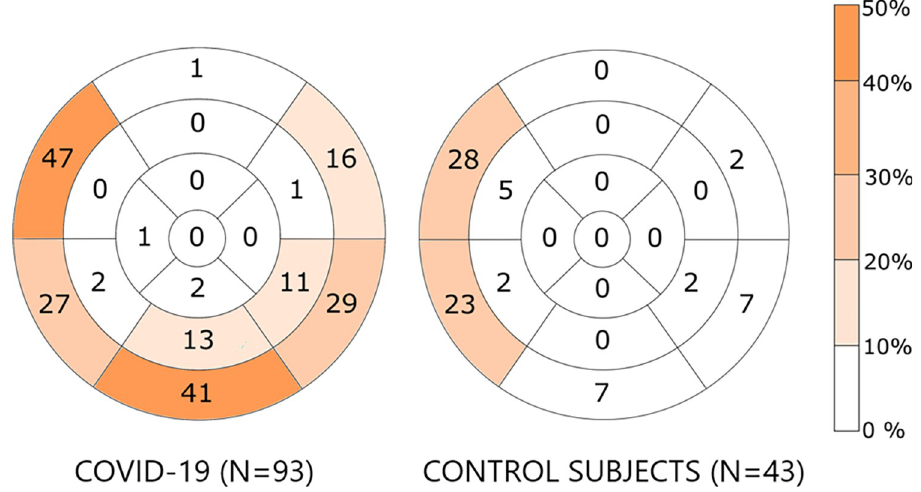
Fig 3. Localization of myocardial late gadolinium enhancement on magnetic resonance imaging in patients with and without coronavirus disease 2019 hospitalization. Localization of late gadolinium enhancement on magnetic resonance images in individuals with and without coronavirus disease 2019. Data are presented according to the American Heart Association’s 17-segment model. Data are presented as percentages.